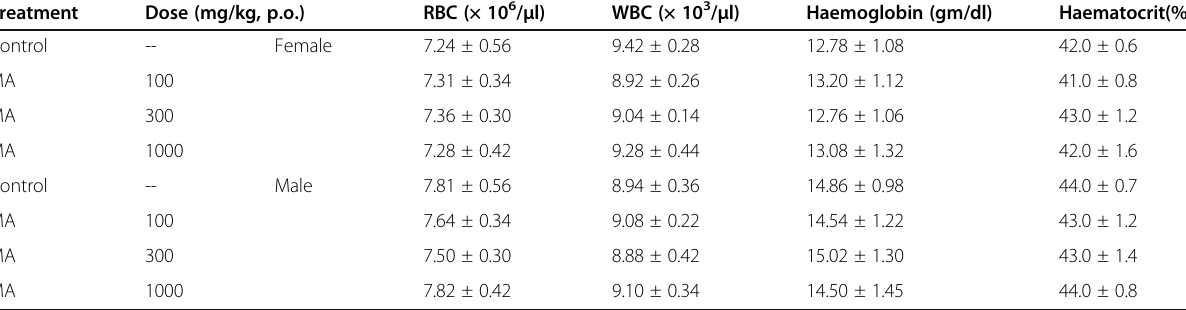
Table 1 Haematological parameters of rats treated with 100, 300 and 1000 mg/kg of MA for a period of 28 days Treatment Dose (mg/kg, p.o.)